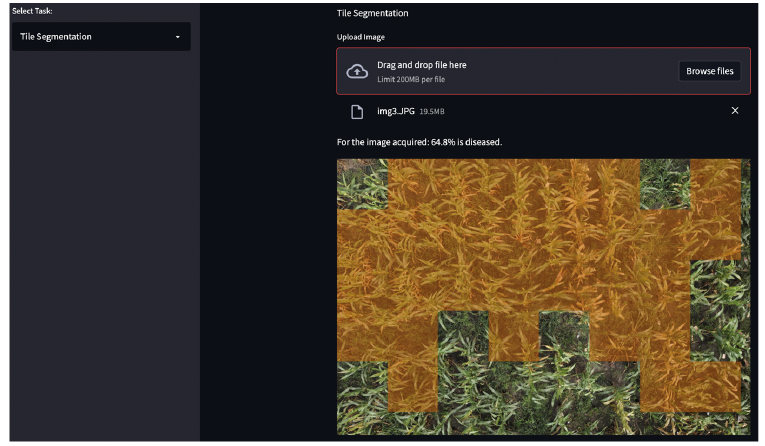
Figure 12. The GeoDLS web application identifies diseased regions in corn